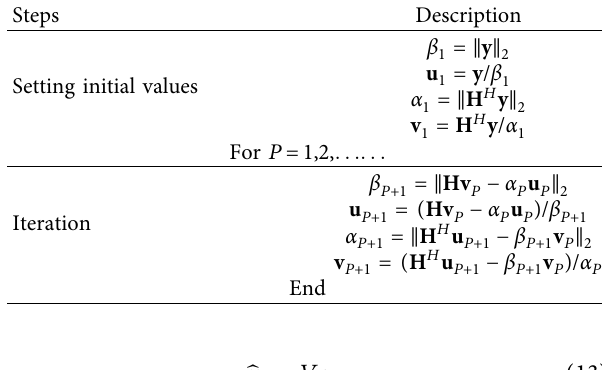
Figure 3: Load decomposition of the steady-state process relied on the LSQR algorithm. Table 3: Golub–Kahan bidiagonalization of the LSQR